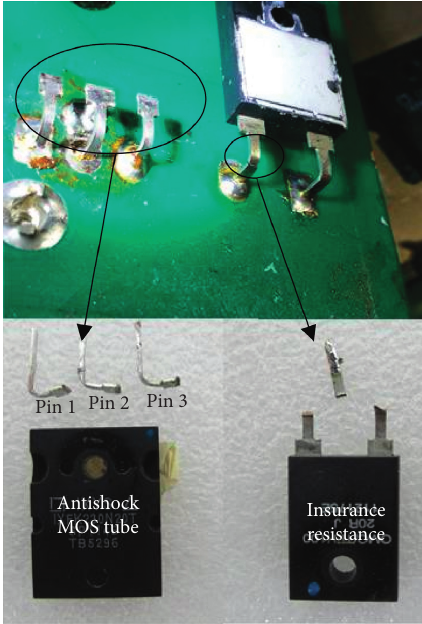
Figure 7: Fracture macromorphology of the semiconductor tube.